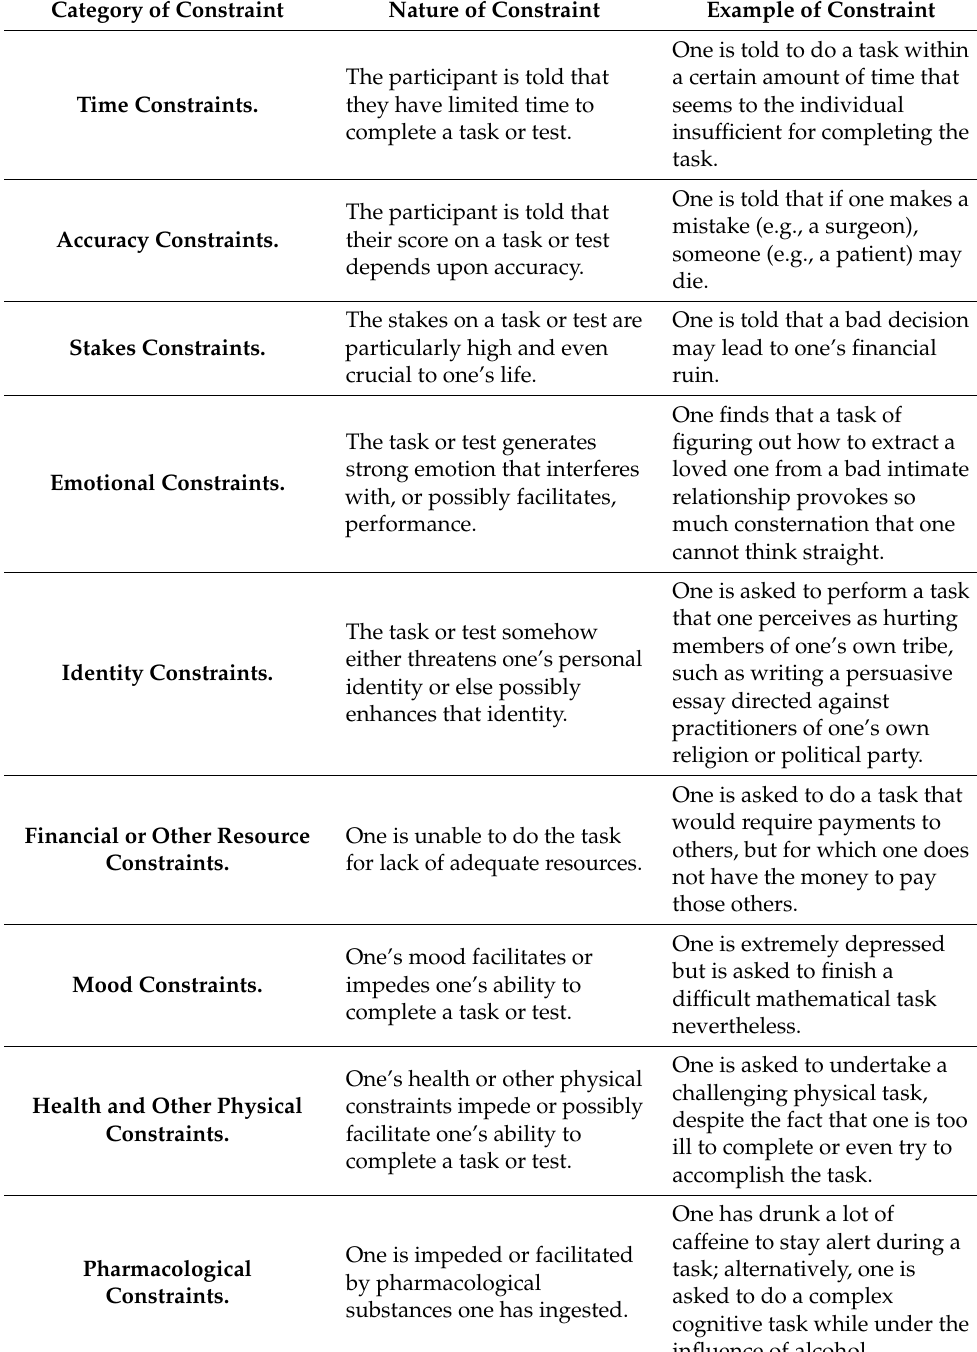
Table 1. Situational variables that can affect intelligent thought and